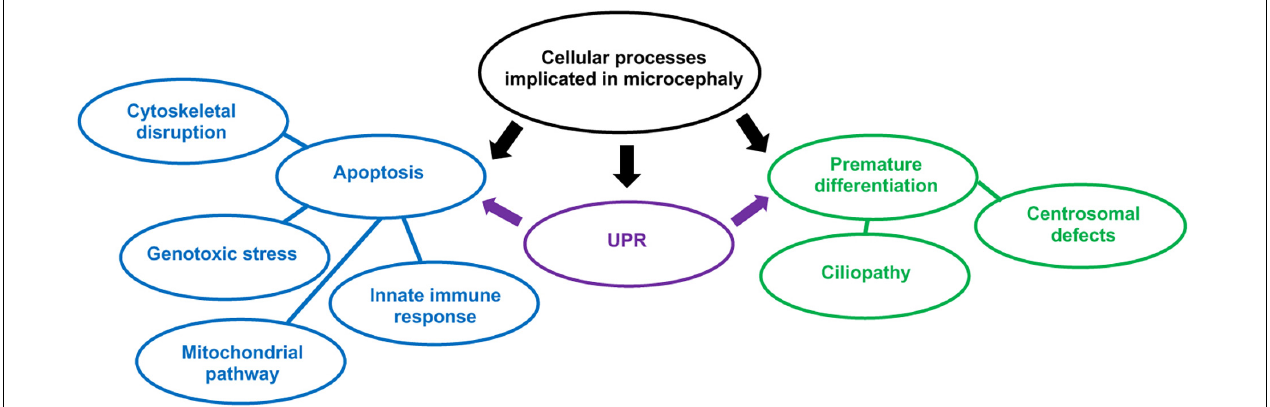
FIGURE 3 | Cellular processes implicated in microcephaly resulting from in utero ZIKV infection. In blue, processes implicated in apoptosis and in green, NPCs premature differentiation. The UPR can trigger both apoptosis and premature differentiation of NPCs.